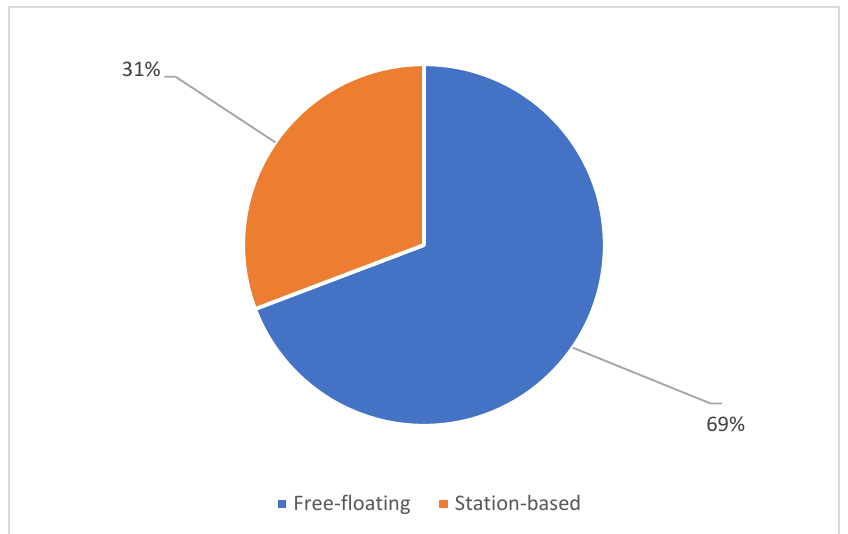
Figure 3. Type of car-sharing services used in operator’s systems.